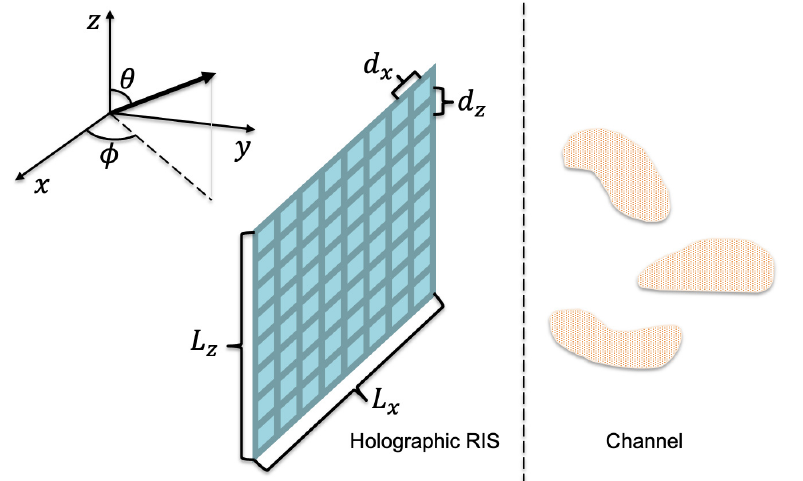
Figure 1. System model and orientation of the holographic reconfigurable intelligent surface (RIS) with respect to the associated coordinate system. The horizontal and vertical lengths of the holo- graphic RIS are L x and L z , with element spacing of d x and d z , respectively. The azimuth and zenith angles are denoted by φ and θ , respectively, and the three irregular blocks in the channel represent random